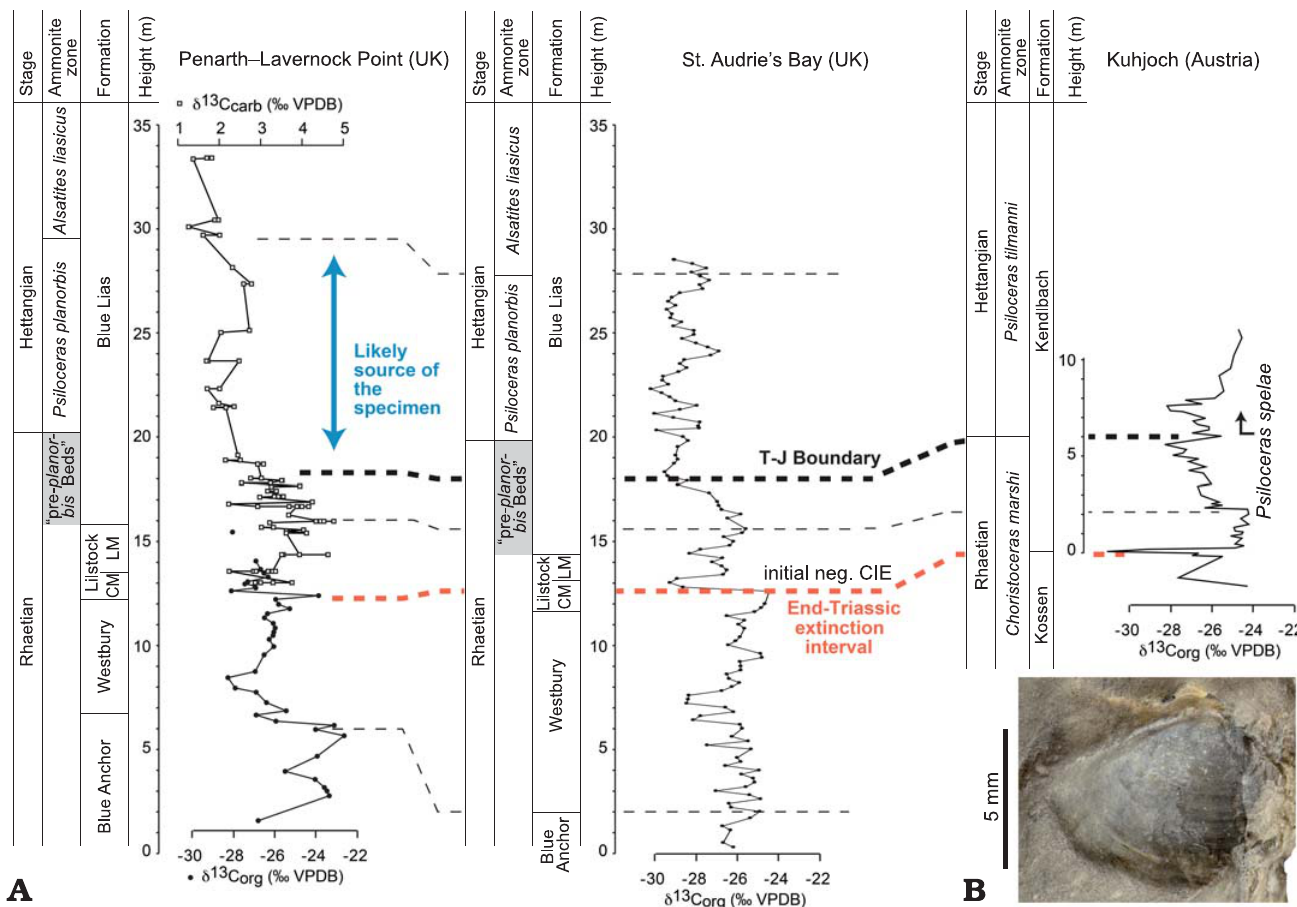
Fig. 1. A . Lithostratigraphy, biostratigraphy, and carbon-isotope stratigraphy of key Triassic–Jurassic sections illustrating the likely age of the specimen NMW95.61G.1 from Penarth, south Wales, UK. Organic and inorganic carbon isotope data of Penarth-Lavernock Point from Suan et al. (2012) and Korte et al. (2009); organic carbon isotope data of St. Audrie’s Bay and Kuhjoch from Hesselbo et al. (2002) and Ruhl et al. (2009). The specimen was deposited several kyr after the end-Triassic mass extinction (initial neg. CIE = initial negative carbon-isotope excursion). Abbreviations: CM, Cotham Member; LM, Langport Member. B . Close-up photograph of the bivalve Palaeonucula navis (Piette, 1858) preserved in the embedding matrix of specimen